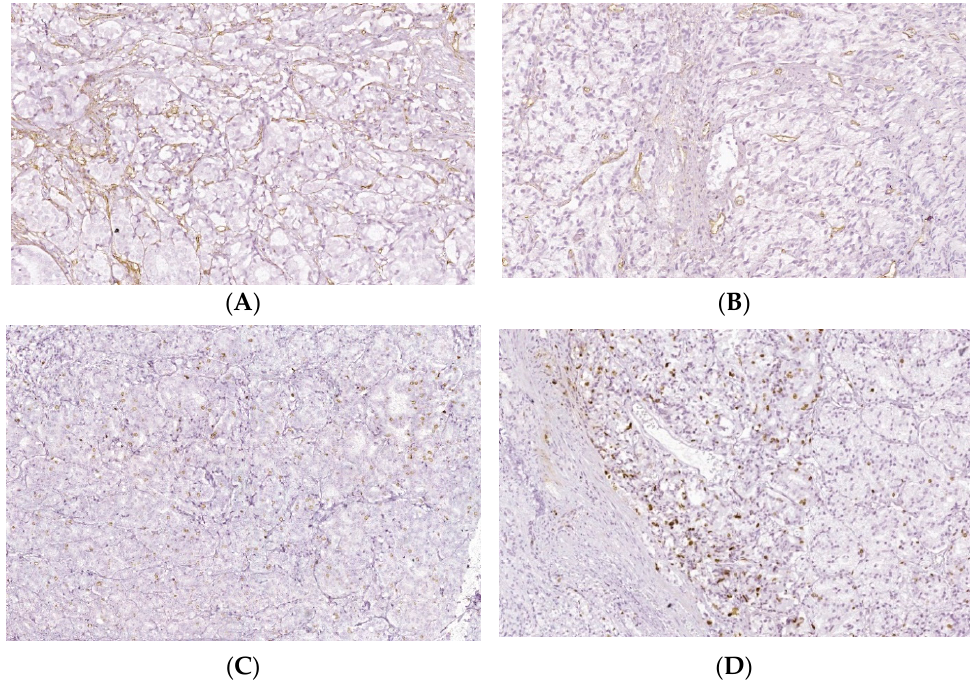
Figure 5. T cell infiltrates from areas of PCa and BPH tissue samples. Legend: ( A ) Microscopic ap- pearance of benign prostatic hyperplasia, usual staining (×20); ( B ) prostate adenocarcinoma, usual staining, Gleason score 3 + 4 (×20); ( C ) CD4-positive peritumoral lymphocytes, more than 50 cells/HPF, prostate adenocarcinoma, Gleason score 3 + 4 (×20); ( D ) CD4-intensely positive in the The intratumoral expression of CD34 showed a significantly increased pattern of PCa peritumoral stroma, more than 50 cells/HPF, prostate adenocarcinoma, Gleason score 4 + 5 (×20); ( E ) tissue samples reported to controls (26.12 ± 6.84 vs. 1.50 ± 0.70, p < 0.01, Table 5, Figure 6). CD3-positive (adenocarcinoma, Gleason score 4 + 5), less than 50 cells /HPF (×20); ( F ) CD8-positive In addition, Ki-67 was expressed in only PCa tissue samples, the score of cell proliferation (adenocarcinoma, Gleason score 4 + 4), more than 50 cells /HPF (×20). being below 25% (score 1+) for all studied PCa cases (Figure 6).